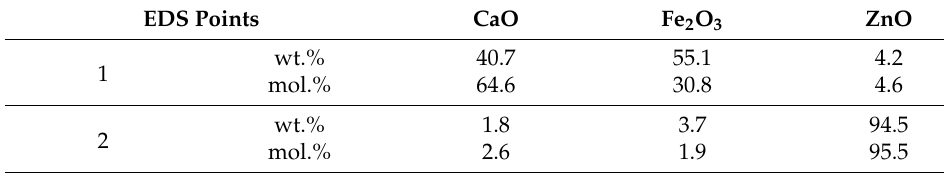
Table 4. EDS analysis of the roasted product with the roasting time of 2 h. EDS